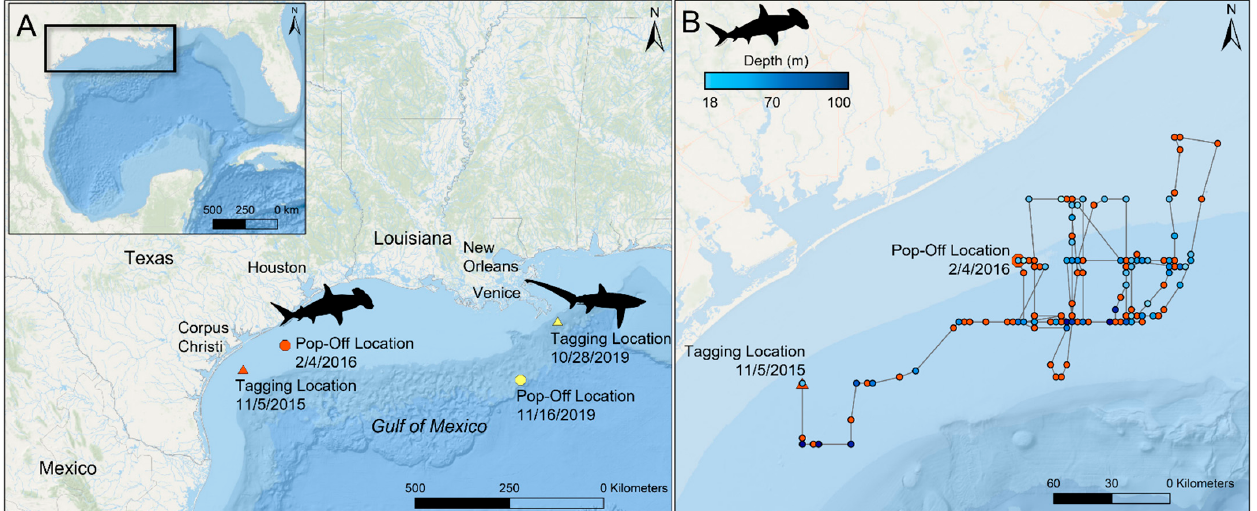
Figure 1. ( A ) Satellite tagging (triangles) and pop ‐ off (circles) locations of the MiniPat (scalloped hammerhead shark; red symbols) and the high ‐ rate PSAT X ‐ tag (bigeye thresher shark; yellow symbols) in the northern Gulf of Mexico. ( B ) Horizontal position estimates (red points) for the scalloped hammerhead shark from the GPE3 software (Wildlife Computers Inc., Redmond, WA, USA), paired with maximum depth information when possible (blue color scale). Tagging (red triangle) and pop ‐ off location (large red circle) are shown for reference.